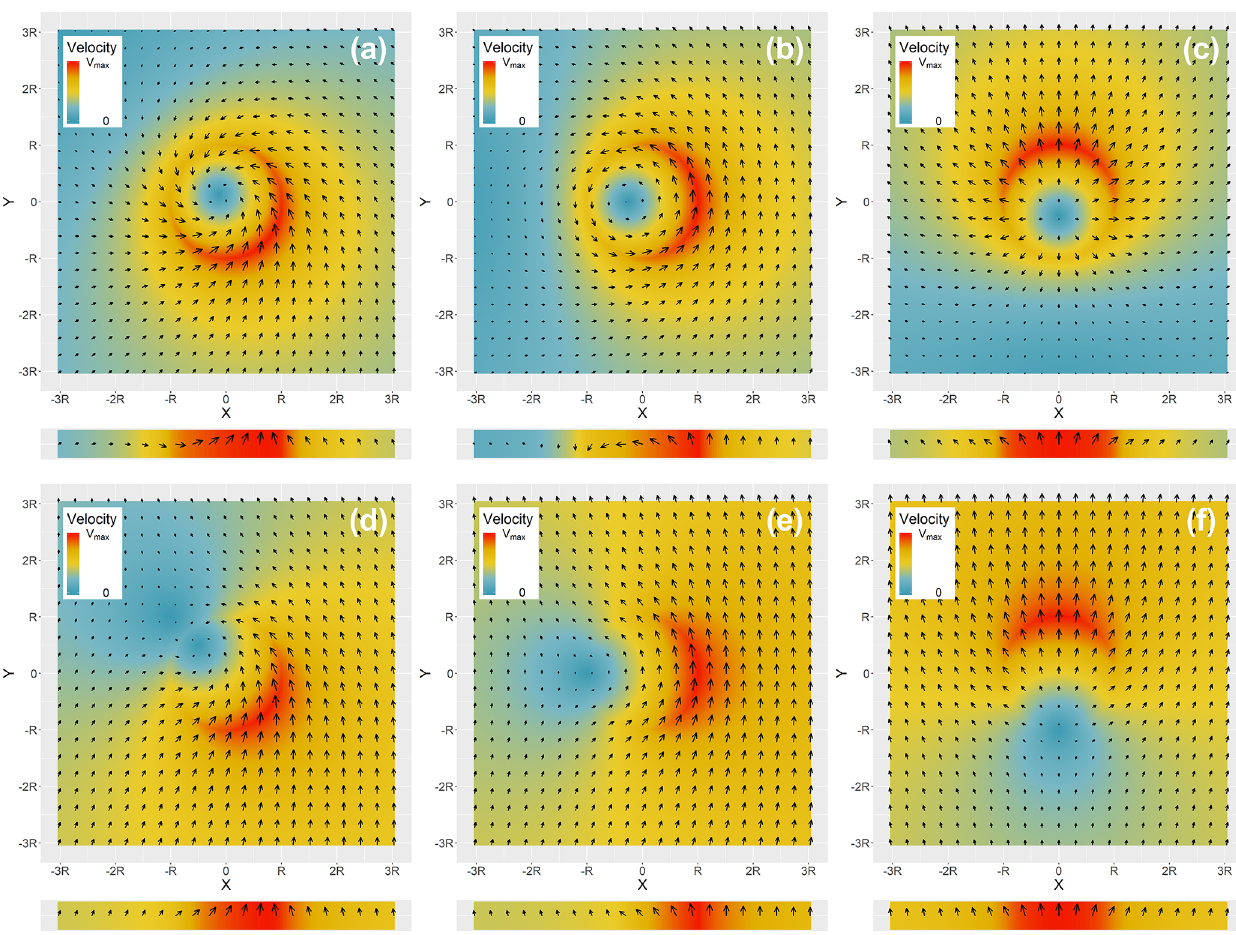
Figure A1. Two-dimensional near-surface horizontal wind fields and damage swaths for the cases: (a) G = 4 and α = 45 ◦ , (b) G = 4 and α = 90 ◦ , (c) G = 4 and α = 180 ◦ , (d) G = 1 and α = 45 ◦ , (e) G = 1 and α = 90 ◦ , and (f) G = 1 and α = 180 ◦ . Adapted from Figs. 3 and 4 of Bech et al. (2009).